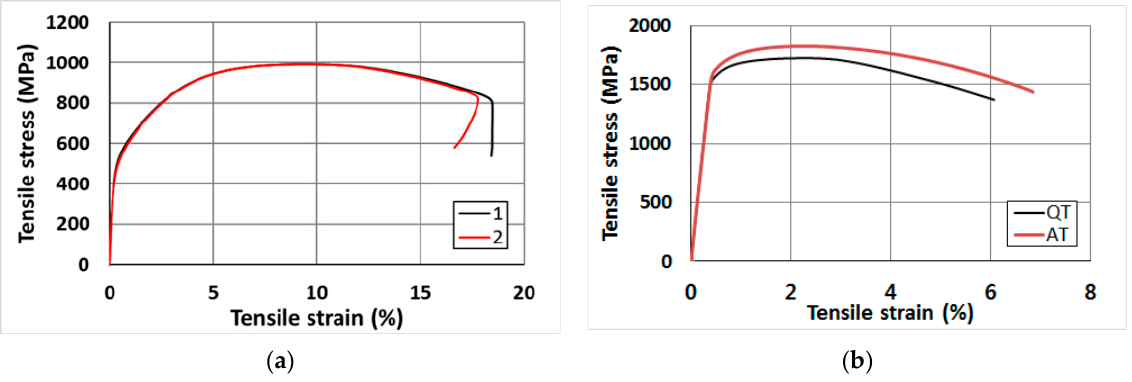
Figure 12. Stress–strain curves of the spring steel. ( a ) AR and ( b ) QT and AT specimens. Table 2. Mechanical properties.